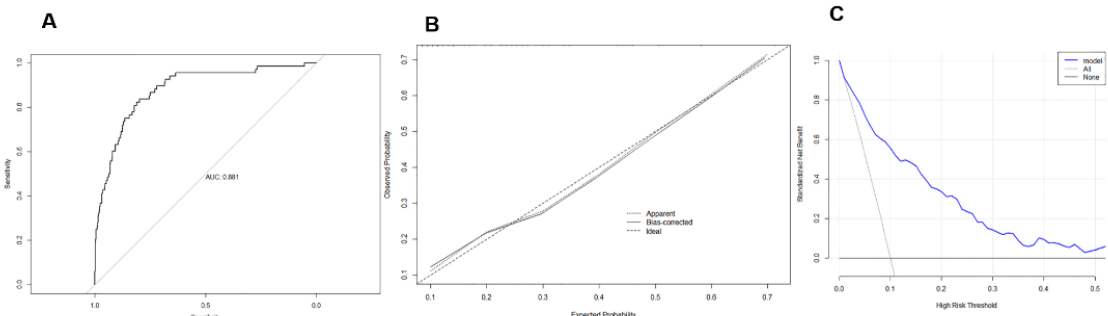
Figure 4. Internal validation of the model. ( A ): the receiver operating characteristic curve of prediction model of left ventricular hypertrophy in patients with postmenopausal hypertension; ( B ): calibration curve of prediction model of left ventricular hypertrophy in patients with postmenopausal hypertension; ( C ): decision curve of prediction model of left ventricular hypertrophy in patients with postmenopausal hypertension.